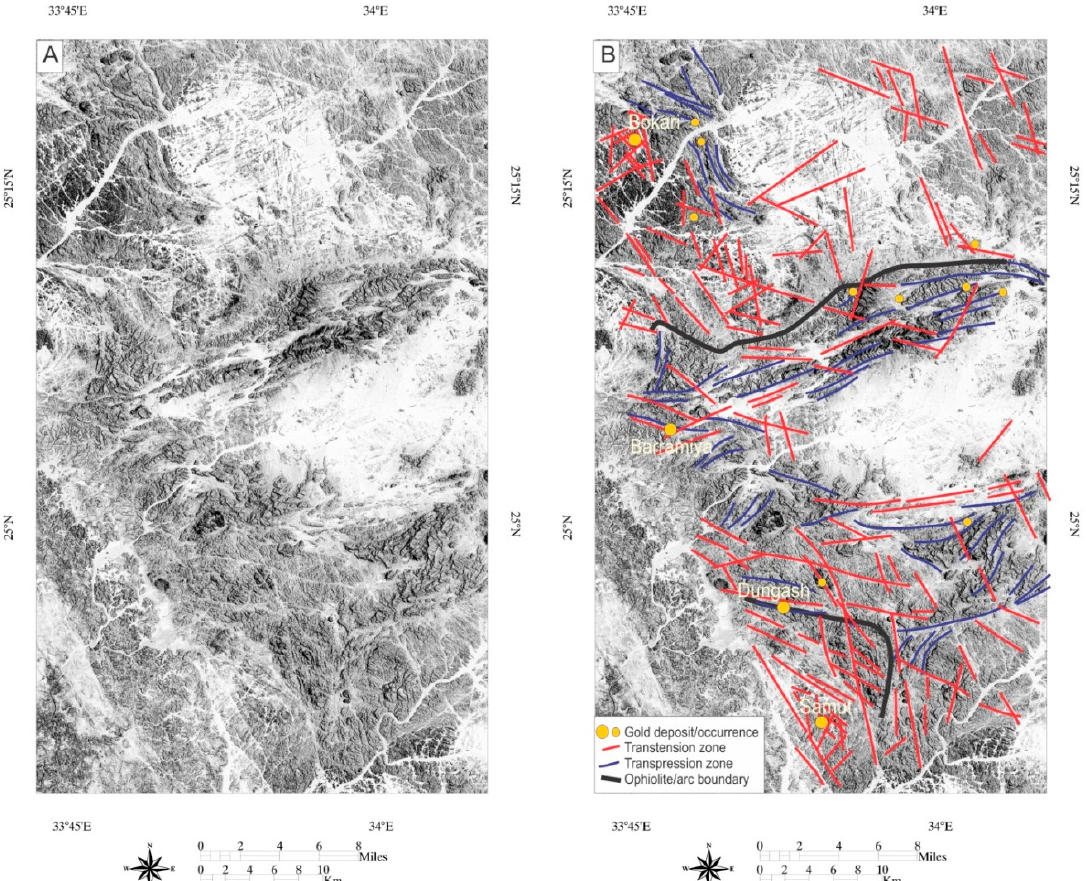
Figure 3. Processed Phased Array type L-band Synthetic Aperture Radar (PALSAR) data of the Barramiya–Mueilha area: ( A ) Feature-oriented Principal Components Selection (FPCS2) image showing fold traces and foliation trajectories most prominent in the central part of the area, ( B ) Same as A with interpreted structural elements and locations of gold deposits/occurrences. The different structural elements are classified based on fieldwork as detailed in the text.